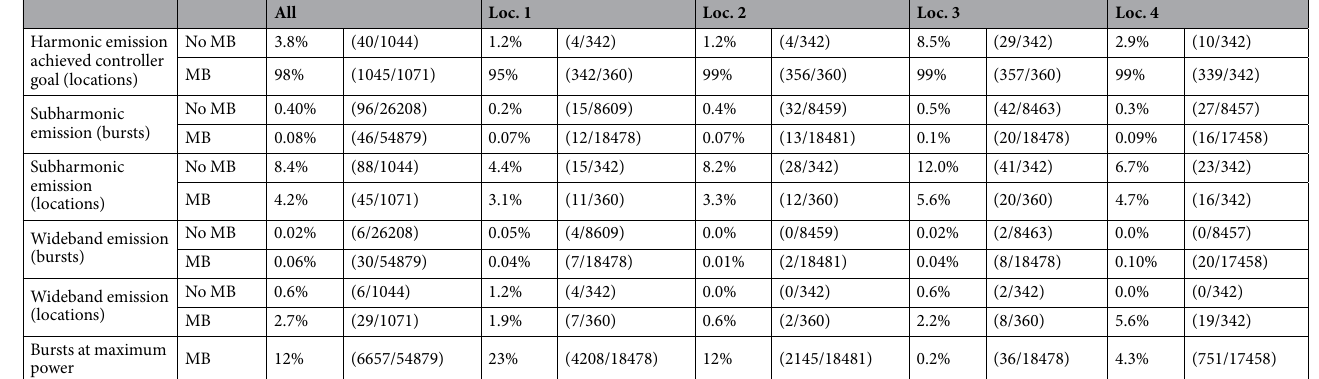
Table 1. Controller performance over 30 consecutive sessions of FUS-induced BBB disruption. (MB: microbubbles).